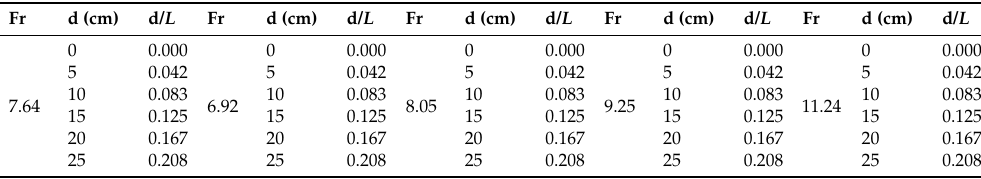
Table 1. The case of Froude number corresponding to the depth of the stilling